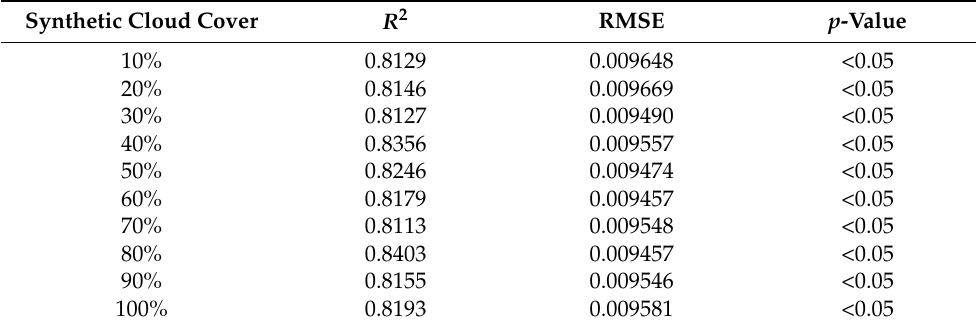
Table 3. Sensitivity of virtual constellation performance to cloud cover in base image for January 2016. Synthetic Cloud